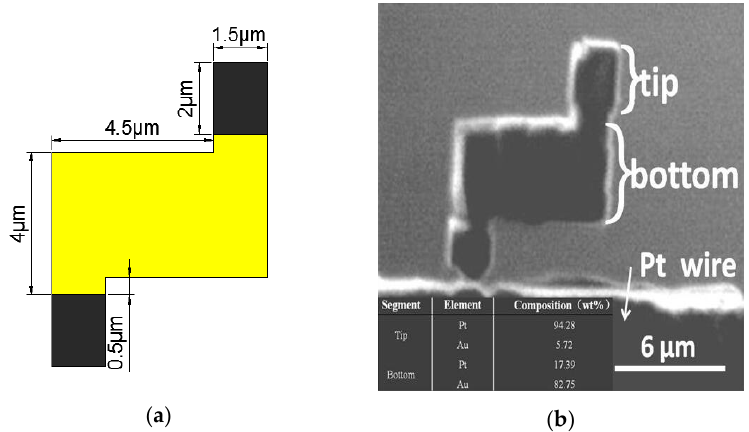
Figure 3. ( a ) The dimension of the Z-shaped nanorobot. ( b ) SEM image of the Z-shaped Au/Pt hybrid nanorobot.